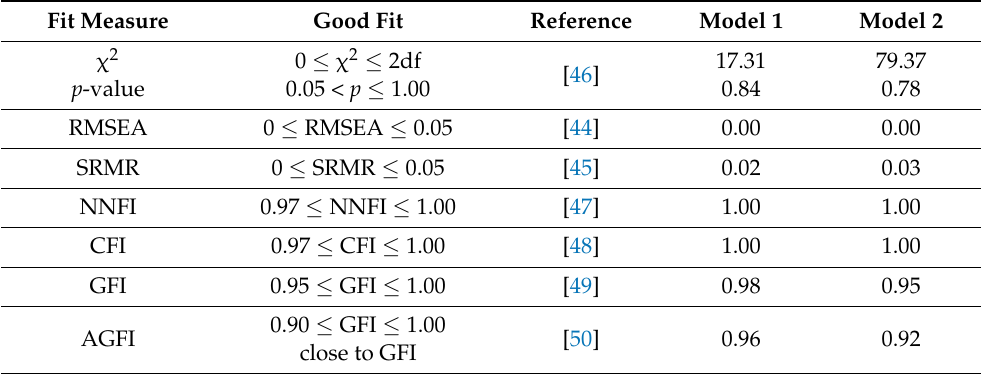
Table 4. Results of the model fit evaluation.